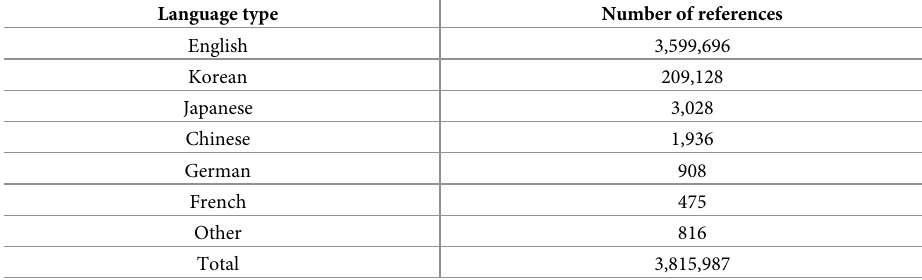
Table 4. Statistics for the number of references for each language in our